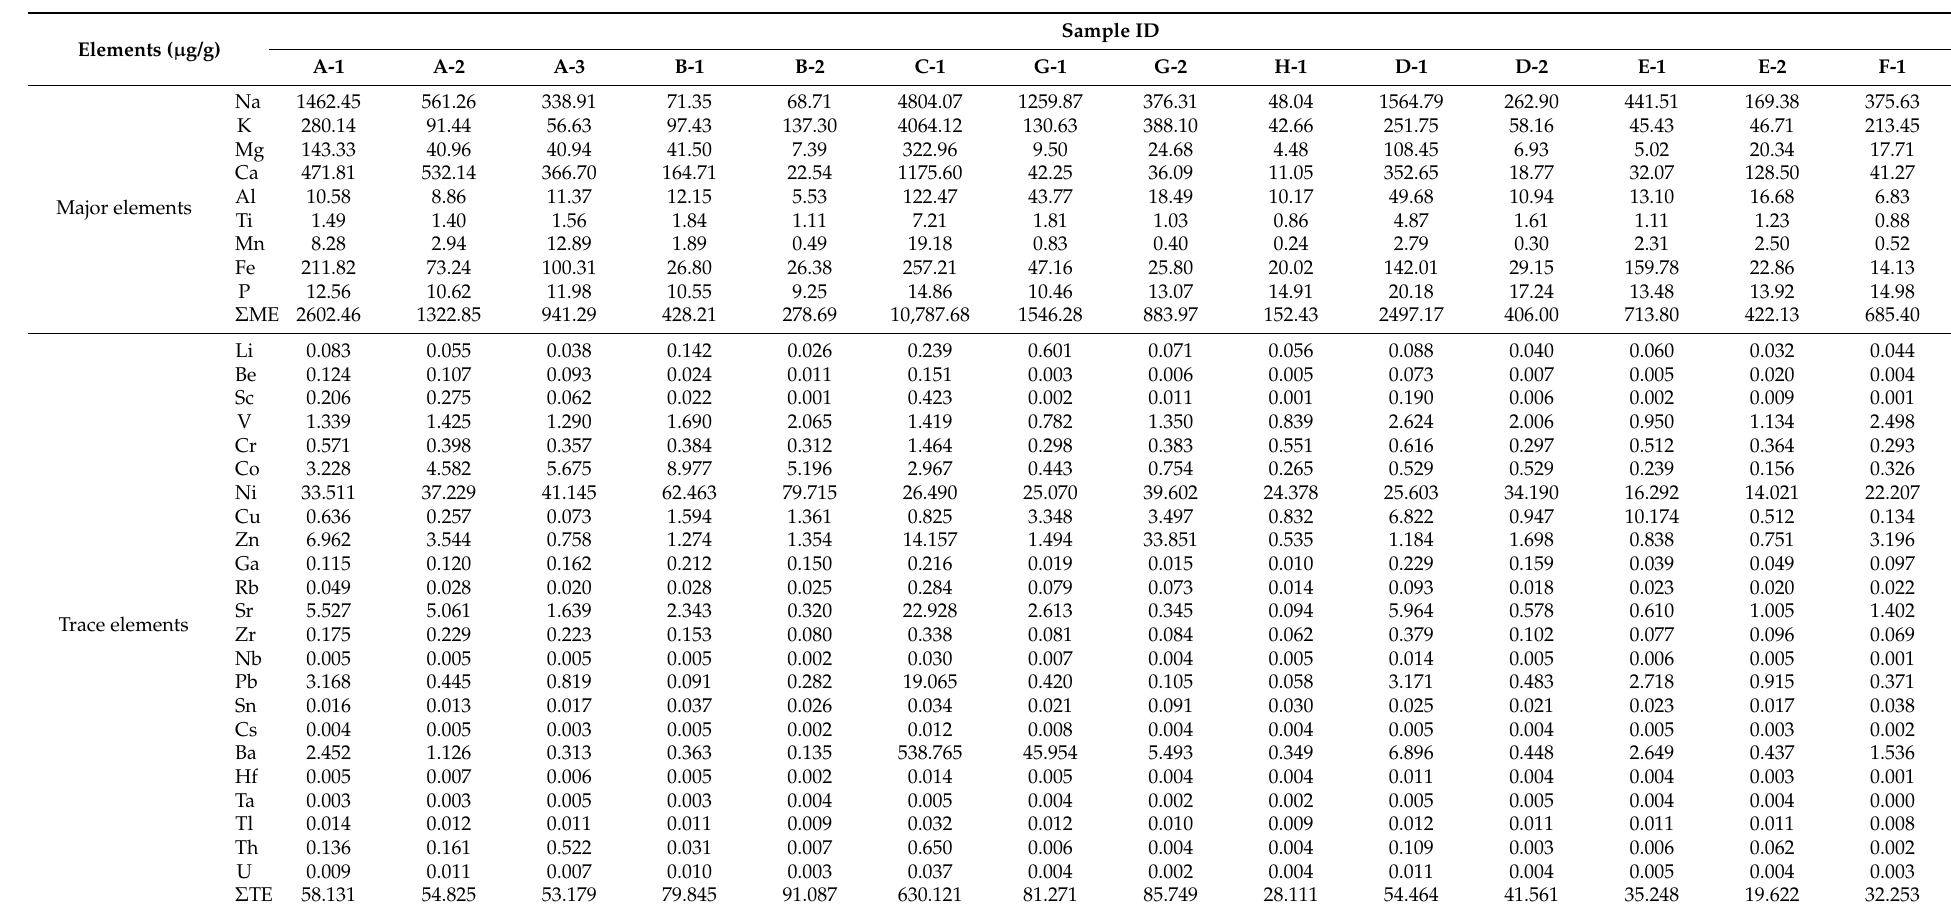
Table 2. Concentrations of major and trace elements in the studied oil